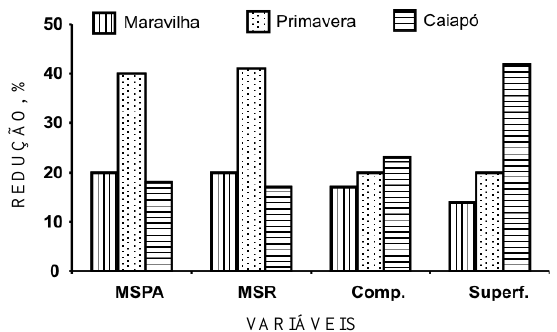
Figura 1. Redução em percentagem entre a menor e a maior dose de boro no solo para as variáveis matéria seca de parte aérea (MSPA), matéria seca de raiz (MSR), comprimento (Comp.) e superfície (Superf.)